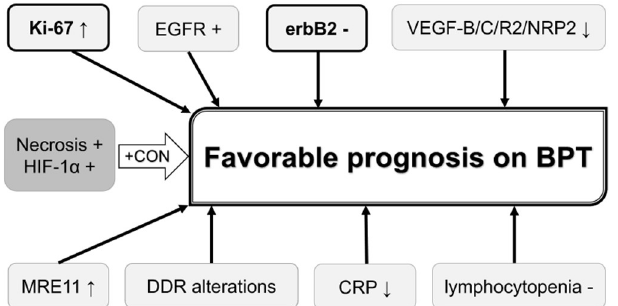
Figure 2. Biomarkers that may be used for predicting and improving prognosis on bladder preservation therapy. Biomarkers in bold letter are also associated with favorable chemoradiation response. Biomarkers in dark shadow are associated with unfavorable clinical outcomes, which can be overcome by CON. BPT, bladder preservation therapy; CON, carbogen and nicotinamide; CRP, C-reactive protein; DDR, DNA damage response; EGFR, epidermal growth factor receptor; erbB2, erythroblastic leukemia viral oncogene homolog 2; HIF-1 α , hypoxia-inducible factor-1 α ; MRE11, meiotic recombination 11; NRP2, neutropilin 2; VEGF, vascular endothelial growth factor; ↑ , increased expression; ↓ , decreased expression or low value.